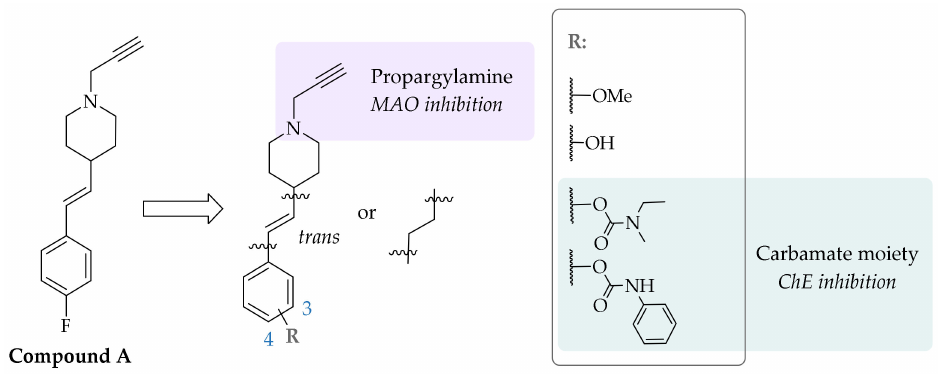
Figure 1. Starting compound A and designed N -propargylpiperidine